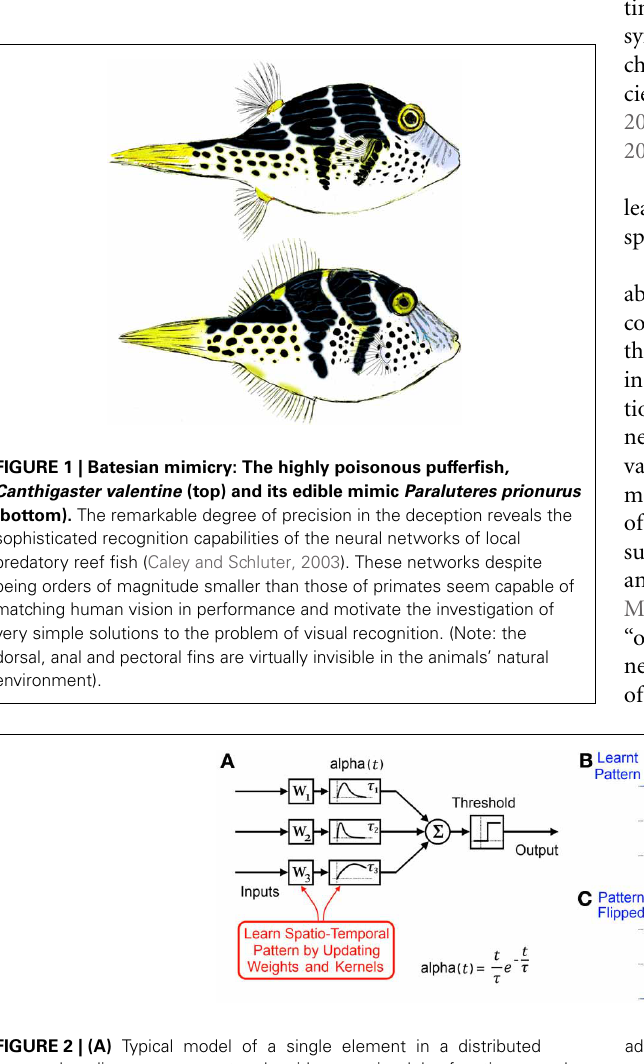
adaptation of synaptic weights and kernels a specific spatio-temporal pattern is learnt by the neuron. (C) Flipping the pattern as would happen if a 2D image were rotated by 180 degrees results in the pattern not being